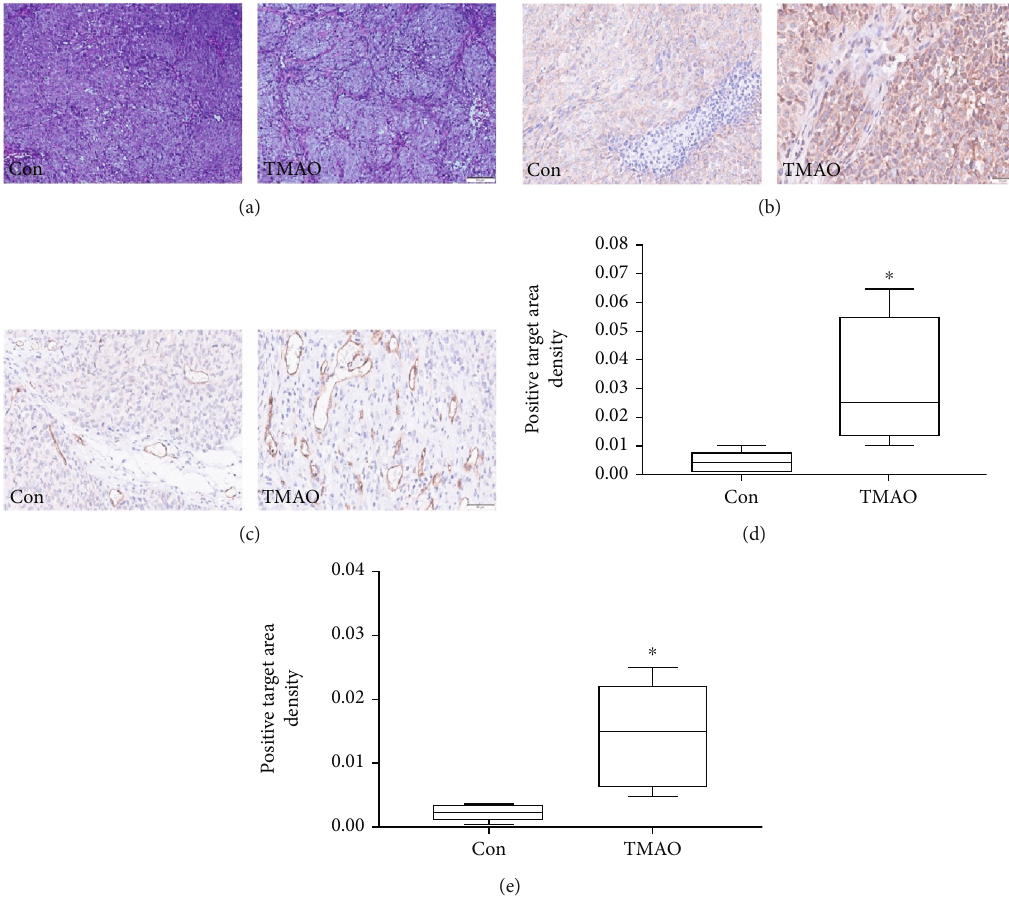
Figure 5: H&E-stained sections and immunohistochemical staining for VEGFA and CD31 in tumor specimens from tumor-bearing animals. (a – c) Representative micrographs of H&E, VEGFA, and CD31 staining. (d – e) Quantitative analysis of VEGFA and CD31 levels. Con: control group; TMAO: 1.3% choline feeding. ∗ P < 0 : 05 versus Con group ( n = 5